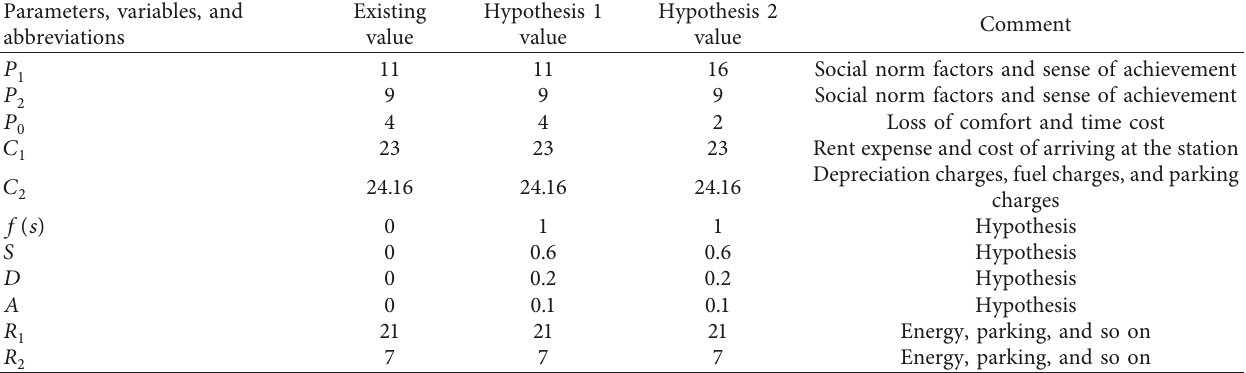
Table 6: Parameters and variables in